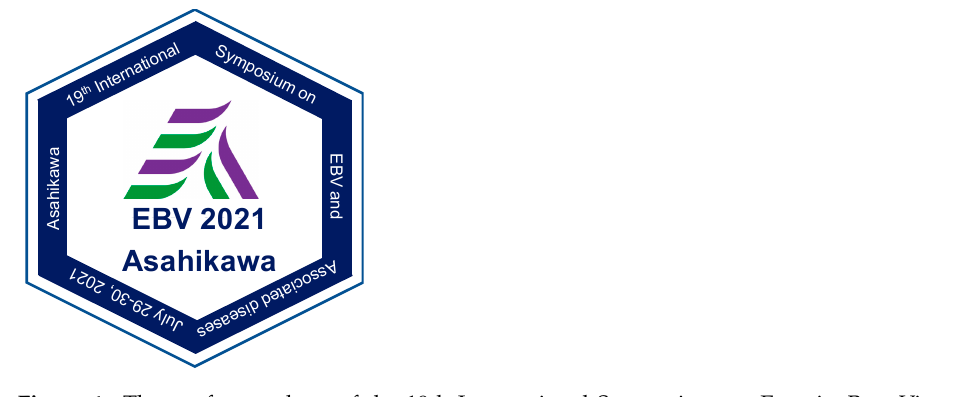
Figure 1. The conference logo of the 19th International Symposium on Epstein–Barr Virus and Associated Diseases.